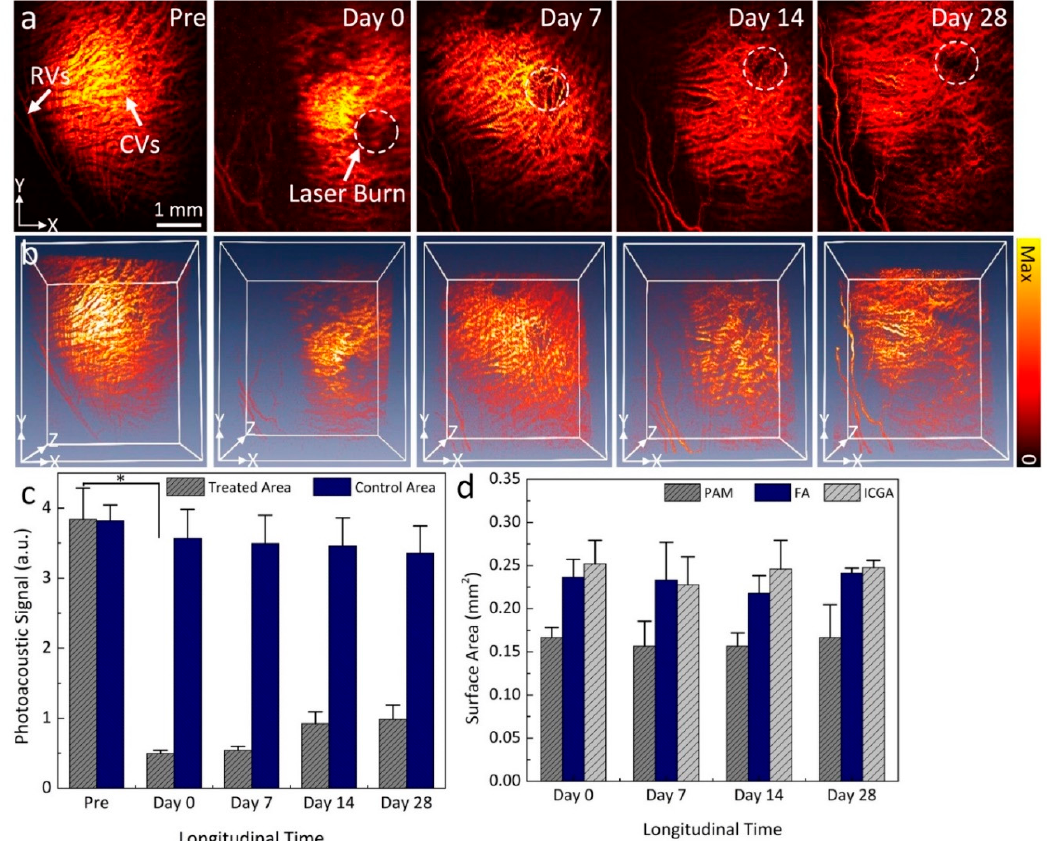
Figure 3. Longitudinal visualization of CVO before and after laser irradiation. ( a ) PAM images obtained at different time points over a period of 28 days post laser-induced CVO. Retinal vessels (RVs) and choroidal vessels (CVs) (white arrows) were visualized on the PAM images obtained before laser irradiation. White dotted circles demonstrate the location of CVO. At the CVO position, the image contrast was reduced in comparison to the surrounding choroidal vessels. ( b ) Three- dimensional (3D) volumetric visualization of PAM images. ( c ) Graph of PAM signal amplitude profiles. ( d ) Surface area of CVO measured by different imaging modalities: PAM, FA, and ICGA. Data presents as mean ± deviation ( n = 3; *: p < 0.001).